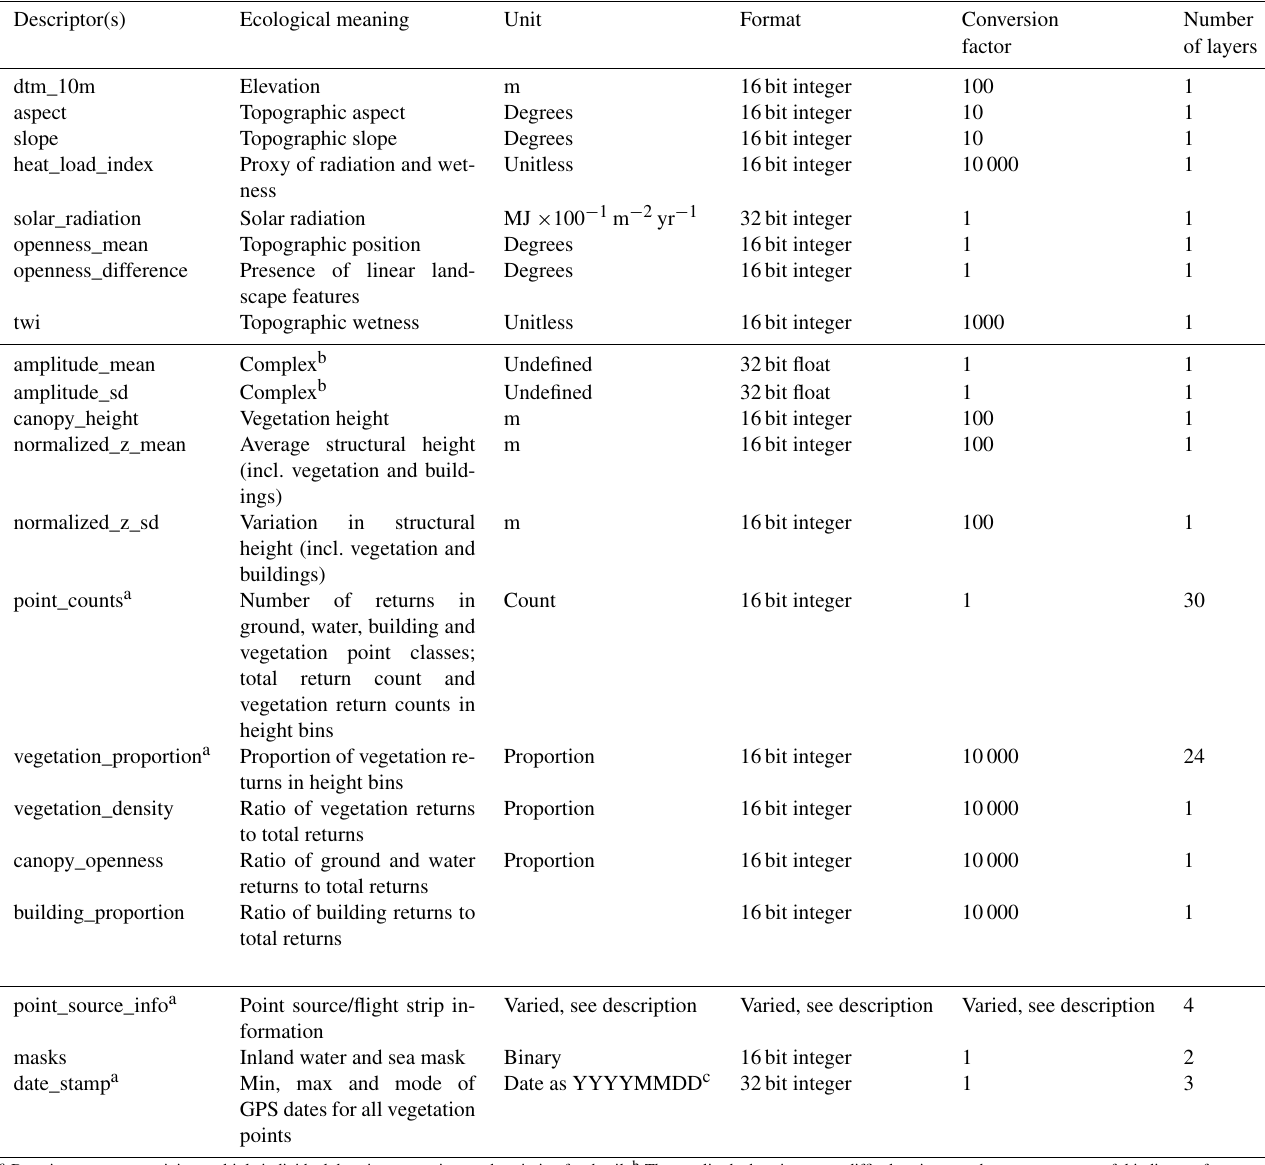
Table 2. Brief overview of the 18 main EcoDes-DK15 descriptors and descriptor groups, their ecological meaning, unit, format and conver- sion factor. See Sect. 3.4 for a detailed description of each descriptor. In addition to the 70 raster layers for the main descriptors, the data set contains 9 layers of auxiliary information (see Sect. 3.7). Note: to obtain the correct unit, the descriptor value needs to be divided by the conversion